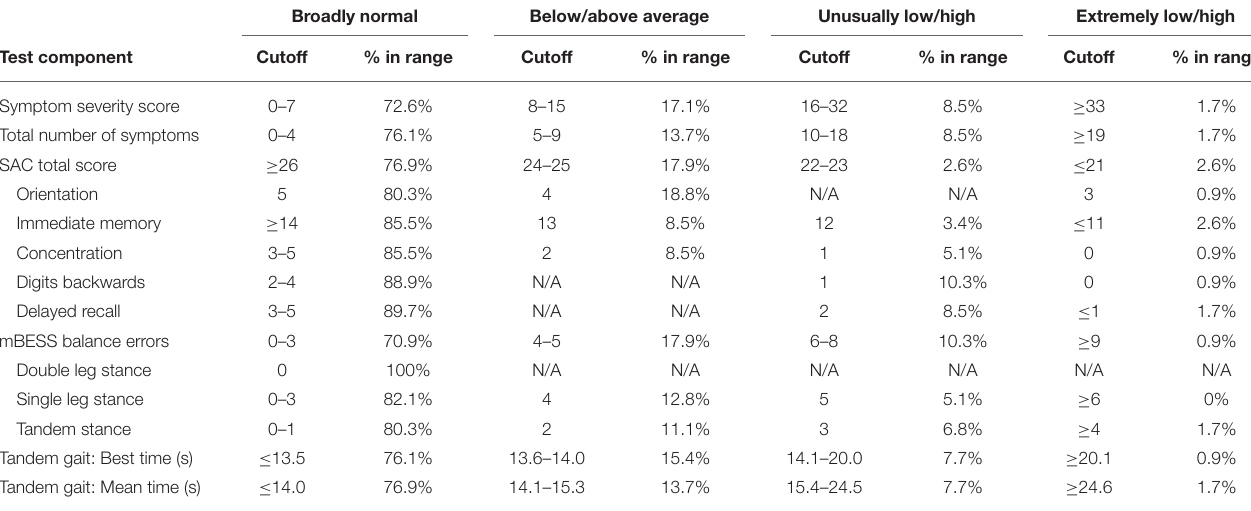
TABLE 3 | Cutoff scores and classification ranges for the SCAT5 components for women professional rugby league